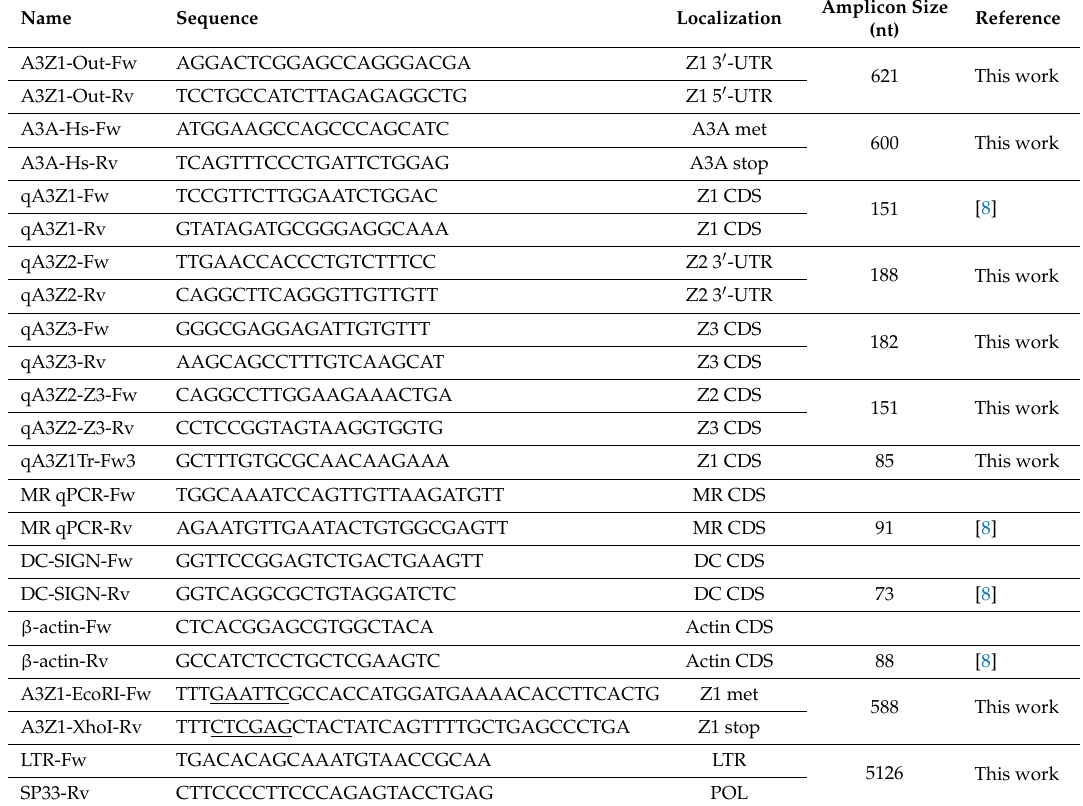
Table 1. Primer pairs